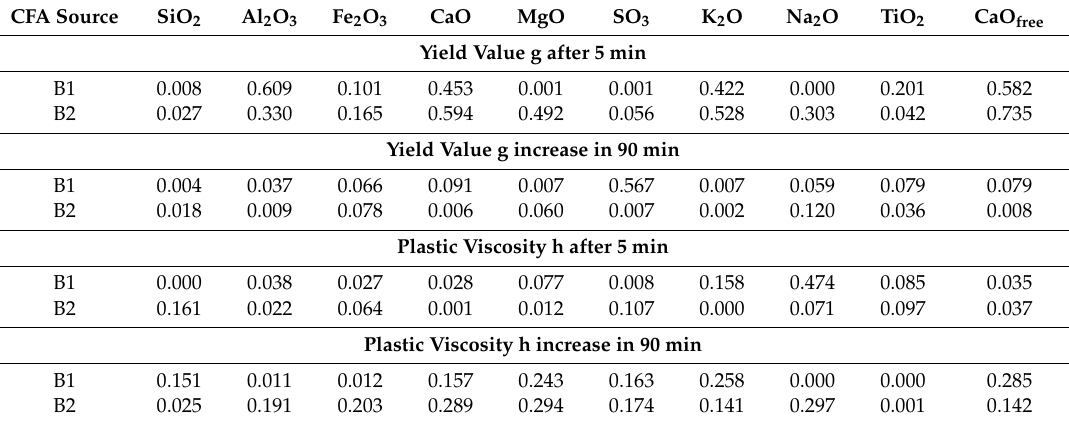
Figure 6. Influence of chemical composition of CFA on the yield value g of mortars. ( a ) Al 2 O 3 , content in CFA, ( b ) CaO content in CFA, ( c ) CaO free content in CFA. Table 9. Matrix of coe ffi cients of determination R 2 for correlations between rheological parameters of CFA mortars and chemical composition of